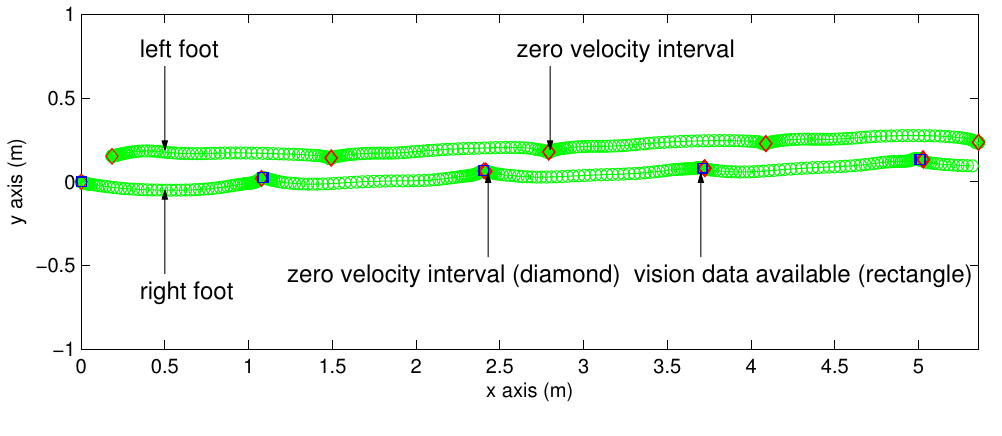
Figure 6. Estimated two feet trajectories on the xy plane.